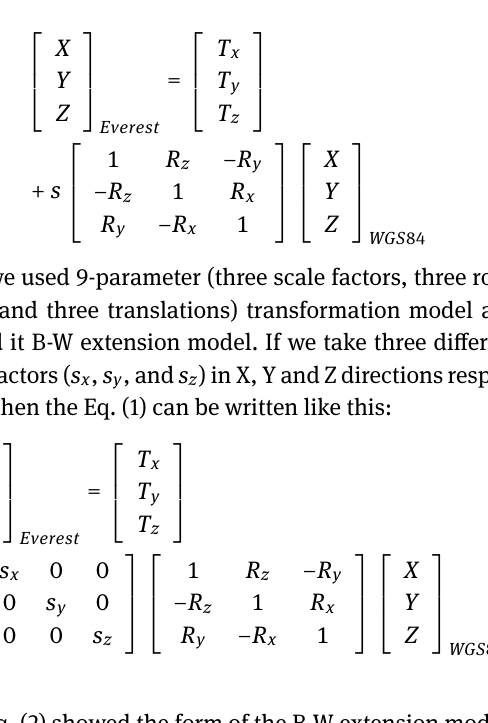
Figure 2: Structure of artificial neural network